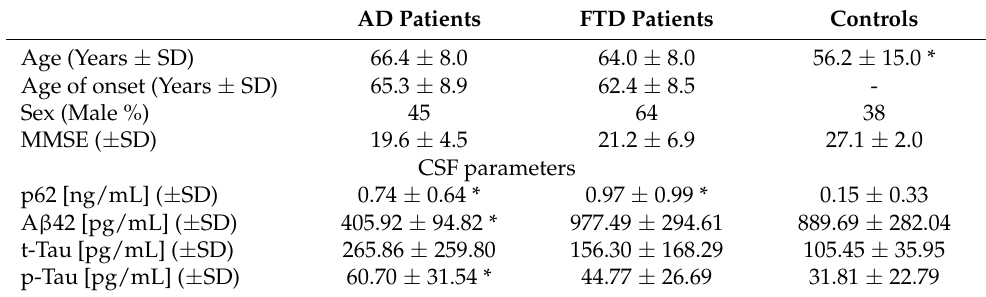
Table 1. Demographic, clinical, and biochemical parameters data of all enrolled subjects. AD